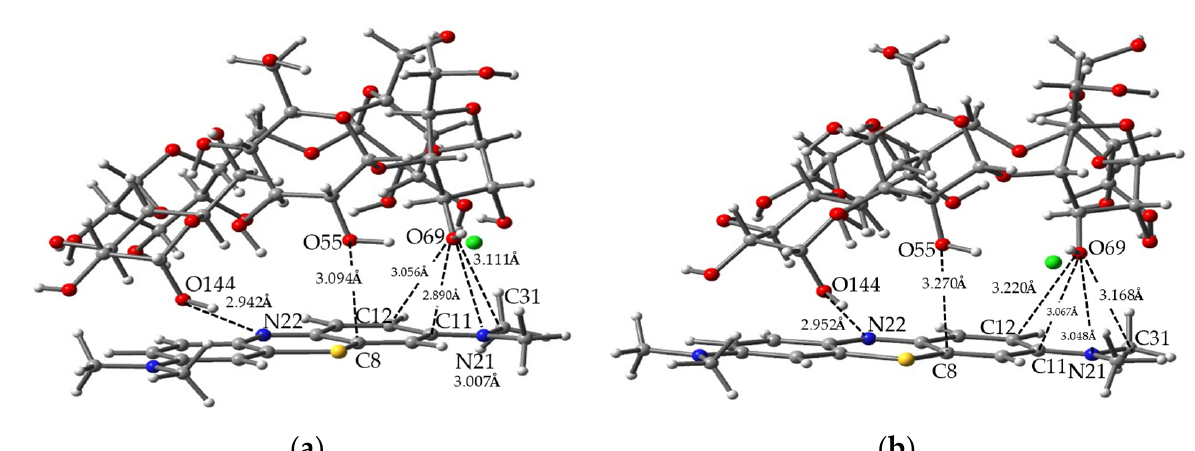
Figure 1. Molecular structures of MB/P 4: ( a ) optimized at the B3LYP/6-31G(d) level and ( b ) optimized at the B3LYP/6-31+G(d,p) level. Weak intermolecular interactions observed are shown with broken lines, with the distances in Å. (Blue ball = nitrogen (N), gray ball = carbon (C), yellow ball = sulfur (S), green ball = chlorine (Cl), red ball = oxygen (O), and white ball = hydrogen (H).) Table 2. Intermolecular interactions observed for MB/pullulan (MB/P) complex.